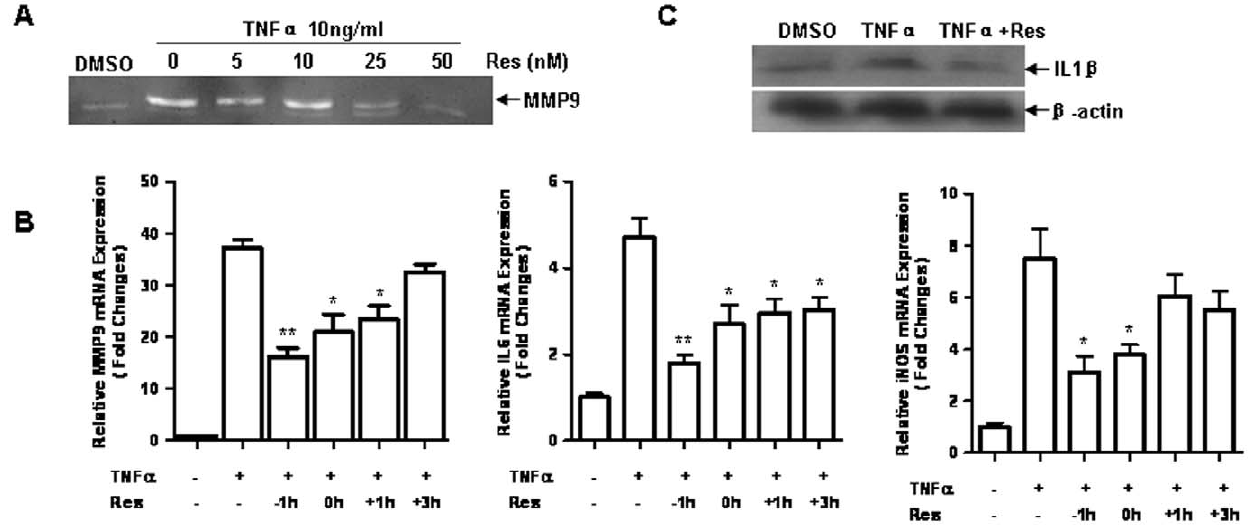
Figure 2. Resveratrol inhibited TNF- a induced inflammation. A. 3T3/NIH cells were pretreated 1 h with varying concentrations of resveratrol (Res) before TNF- a (10 ng/ml) treatment. MMP-9 expression in the medium was examined by gelatin zymography after 24 h treatment. B. Resveratrol (50 nM) was used to treat cells 1, 0 hour before or 1, 3 hours post TNF- a (10 ng/ml), the relative mRNA levels of MMP-9, iNOS and IL-6 were detected by real-time RT-PCR analysis at 6 hours post TNF- a treatment. (n=3 per group, * p , 0.05 vs. TNF- a + /Res-; ** p , 0.01 vs. TNF- a + /Res-). C. Cells were pretreated by resveratrol 1 h before TNF- a , western blotting analysis was used to detect IL-1 b expression after 9 h treatment.